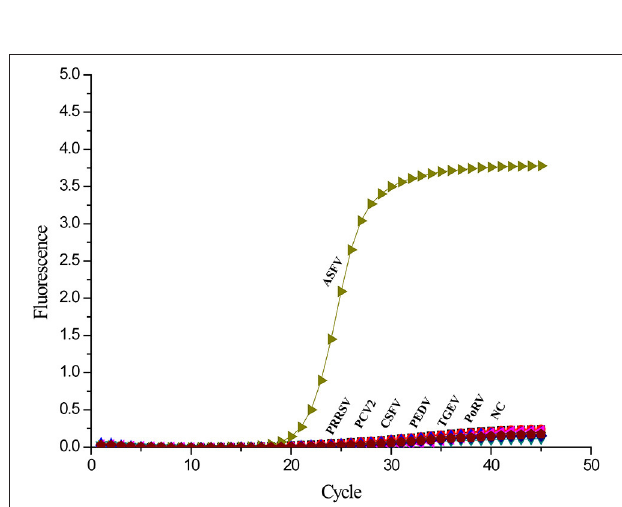
FIGURE 4 | Specificity analysis of the A137R gene-based real-time PCR. Only ASFV showed a positive fluorescence signal, and no positive signal was observed with other swine